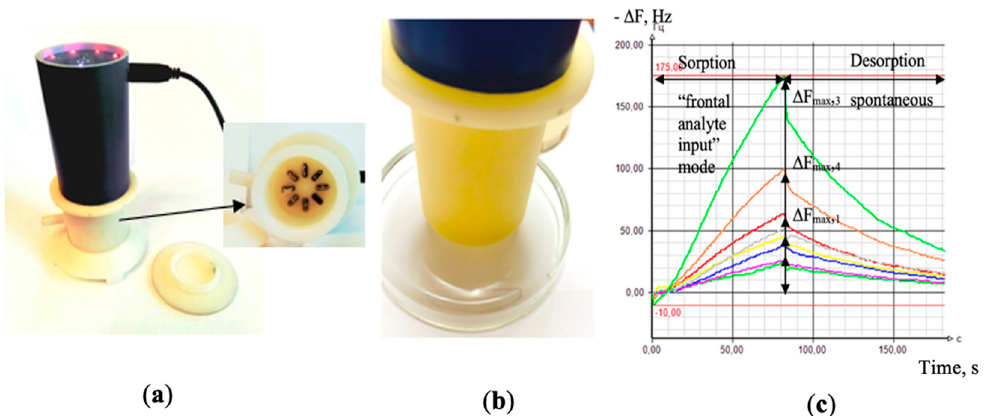
Figure 1. General view of the “Diagnostic-Bio-8” device ( a ); while measuring a sample of nasal swabs ( b ); the output curves of the sensors as appears in the software of the device ( c ).